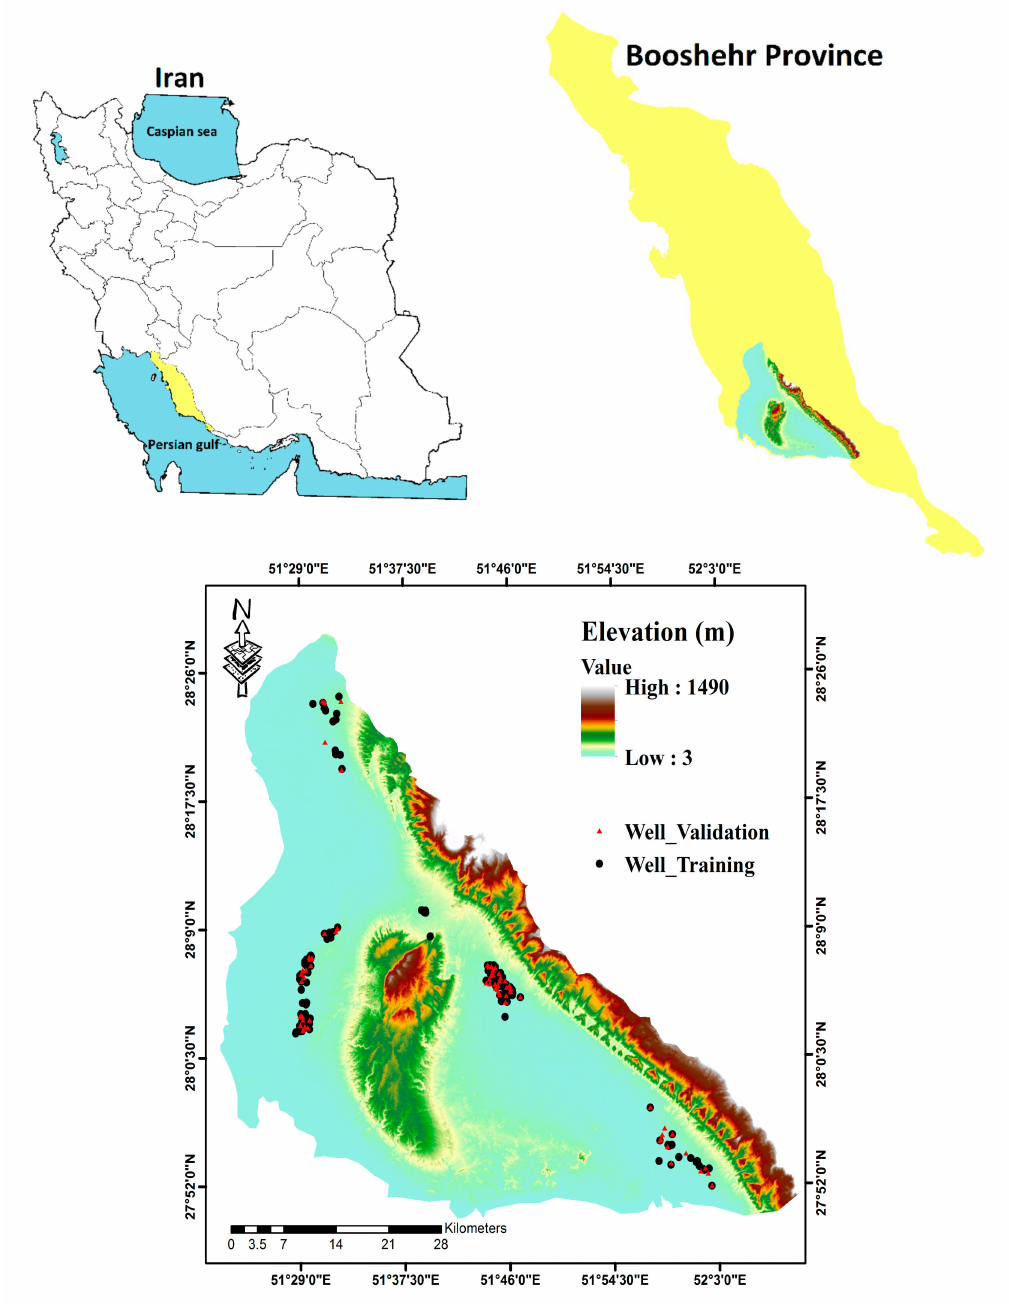
Figure 2. Location of the study